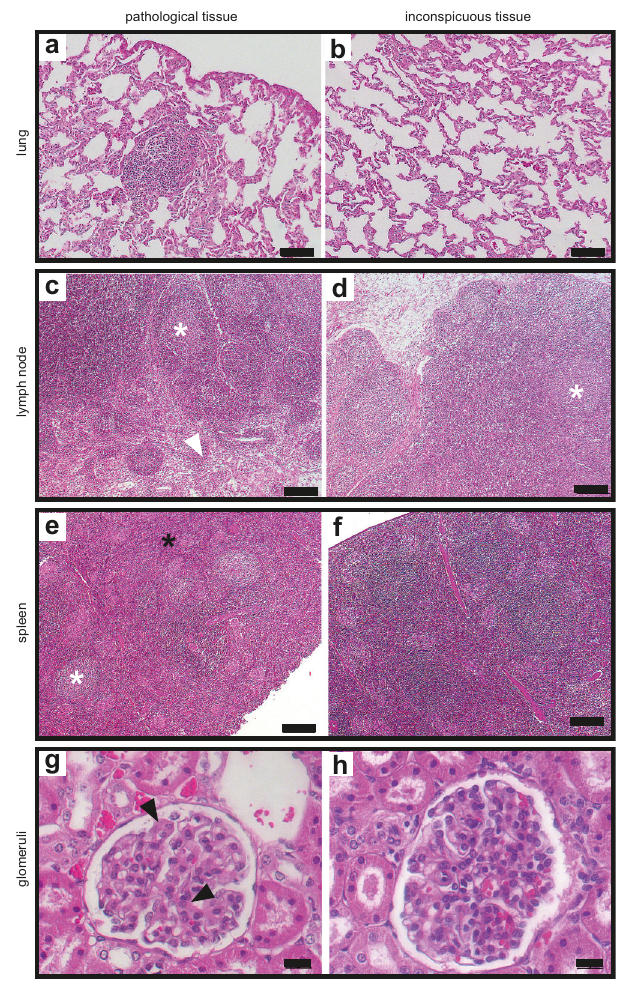
Fig. 4 Histological examination on day 21 post-infection. H&E-stained tissues from all animals of the study ( n = 24) were examined and representative pictures from individual animals are shown. a Perivascular lesion due to lymphocytic in fi ltration in the lung. b Normal lung tissue. c Lymph nodes with germinal centers (white asterisk) and histiocytosis (white arrow). d Normal lymph node. e Spleen with germinal centers (white asterisk) and hematopoiesis (black asterisk). f Normal spleen tissue. g Mesangial proliferation (black arrow) in glomeruli of the kidney. h Normal glomerulus. Black bar represents 100 µ m ( a , b ), 200 µ m ( c – f ), 20 µ m ( g , h ). Representative pictures are shown from untreated group ( c , g , h ), therapeutic day 3 ( a , b , f ), or therapeutic day 7 ( d , e )